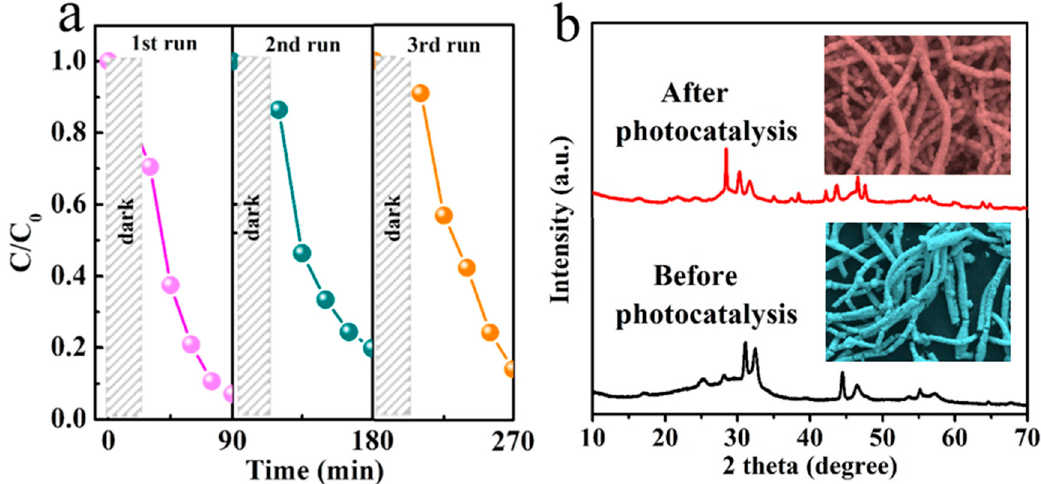
Figure 6. ( a ) Cycling test curves of the AgBr/BiOBr/PAN CMs-2 for the photocatalytic degradation of MO; ( b ) XRD patterns and SEM images of AgBr/BiOBr/PAN CMs-2 before and after three of MO; ( b ) XRD patterns and SEM images of AgBr / BiOBr / PAN CMs-2 before and after three photocatalytic reactions. photocatalytic